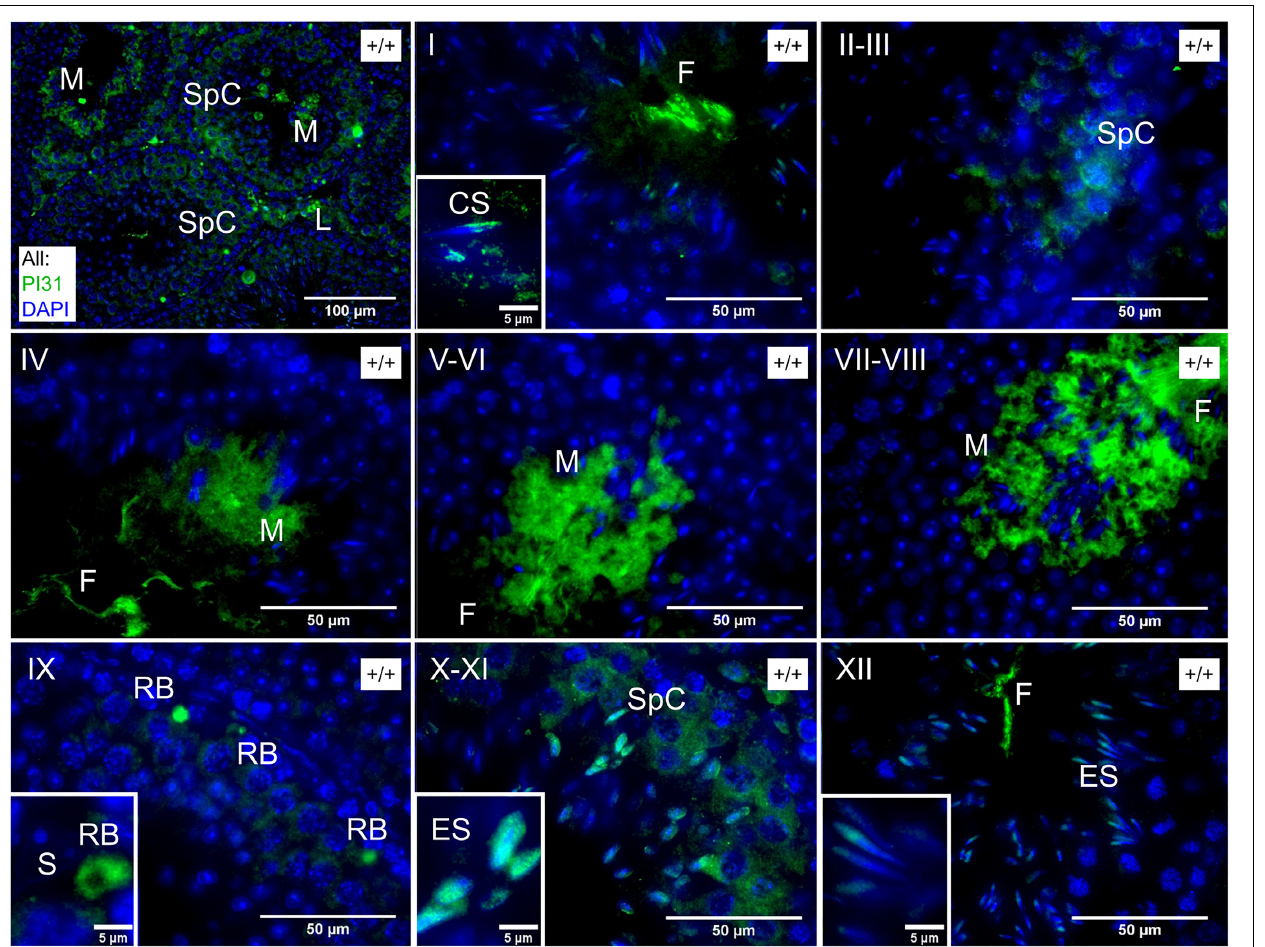
FIGURE 6 | Immunochemical staining of PI31 localisation in wild type testes. Roman numerals indicate tubule stage. PI31 signal is cytoplasmic in Spc/M/RB/L but nuclear in ES and early CS. Key: SpC = spermatocyte, ES = elongating spermatid, CS = early condensing spermatid, M = mature or late condensing spermatid, RB = residual body, L = Leydig cell, S = Sertoli cell, F = flagellum of mature